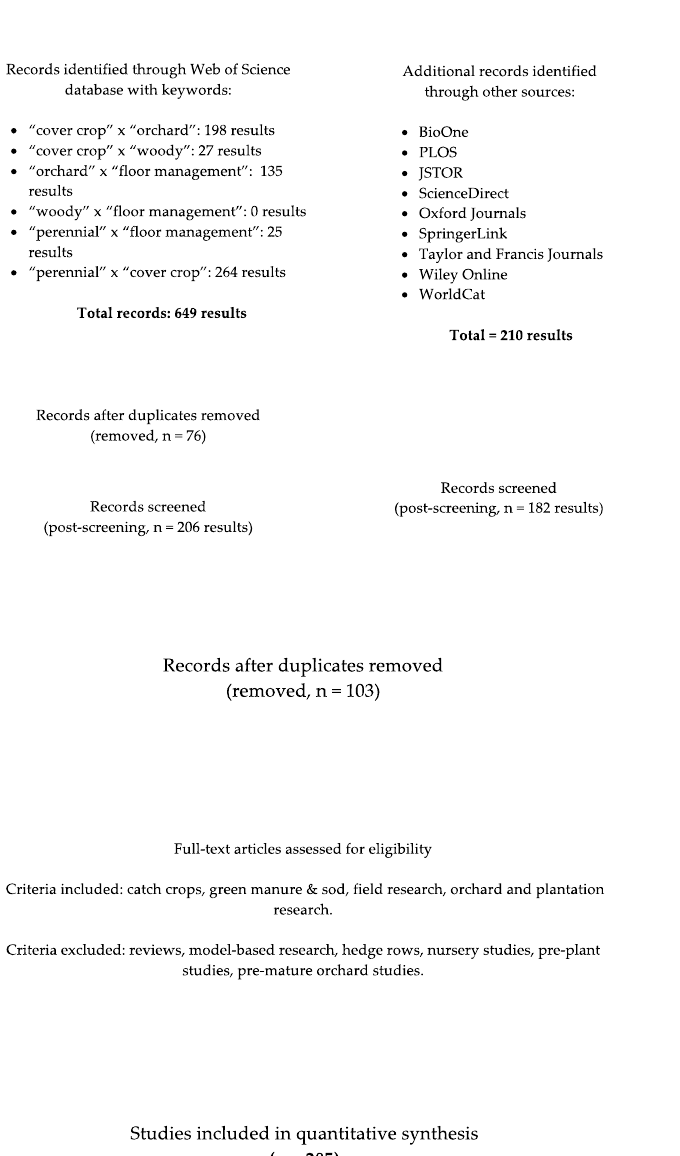
Figure 1. Study review and selection flow chart. Peer-reviewed studies were collected, following the Preferred Reporting Items for Systematic Reviews and Meta-Analyses (PRISMA) process, adapted by Moher et al. [43].